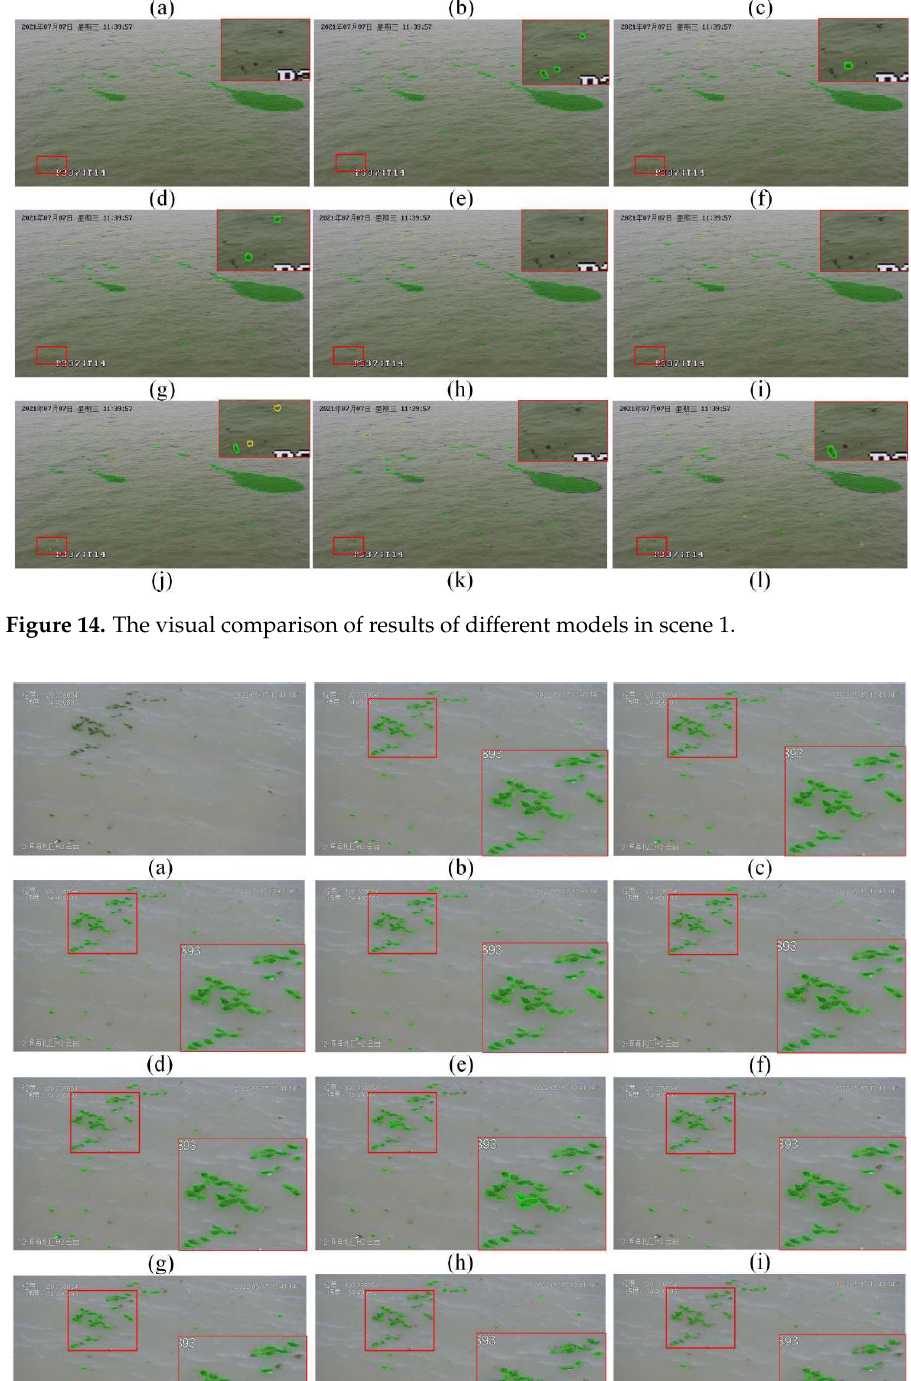
Figure 16. The visual comparison of results of different models in scene 3.